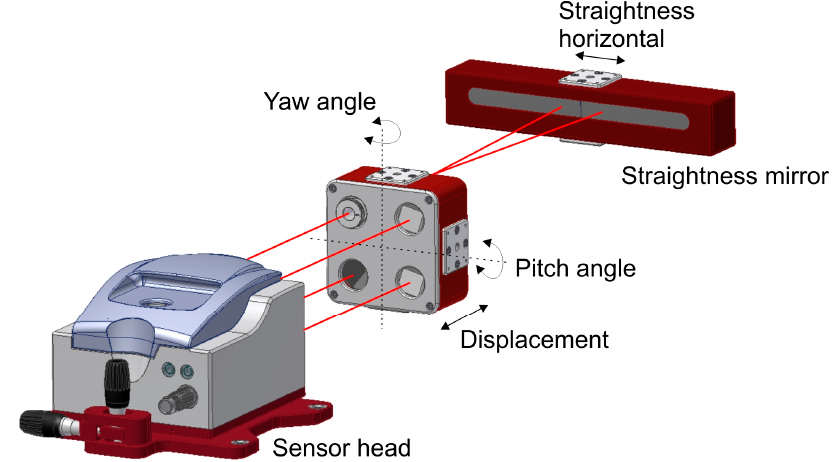
Figure 8. Multidimensional equipment for five dof [78].